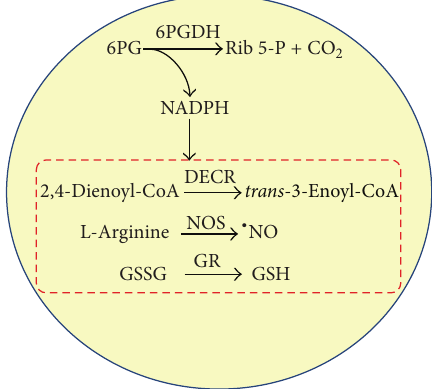
Figure 1: Functions of the endogenous NADPH in plant peroxi- somes. NADPH is required for several enzymatic systems includ- ing the glutathione reductase (GR) to keep the level of reduced glutathione (GSH), the L-arginine-dependent nitric oxide synthase (NOS) which generates nitric oxide (NO), and the 2,4-dienoyl- CoA reductase (DECR) which is necessary for the degradation of fatty acids unsaturated on odd-numbered carbons. 6PGDH: 6- phosphogluconate dehydrogenase. 6PG: 6-phosphogluconate. Rib 5-P: ribulose